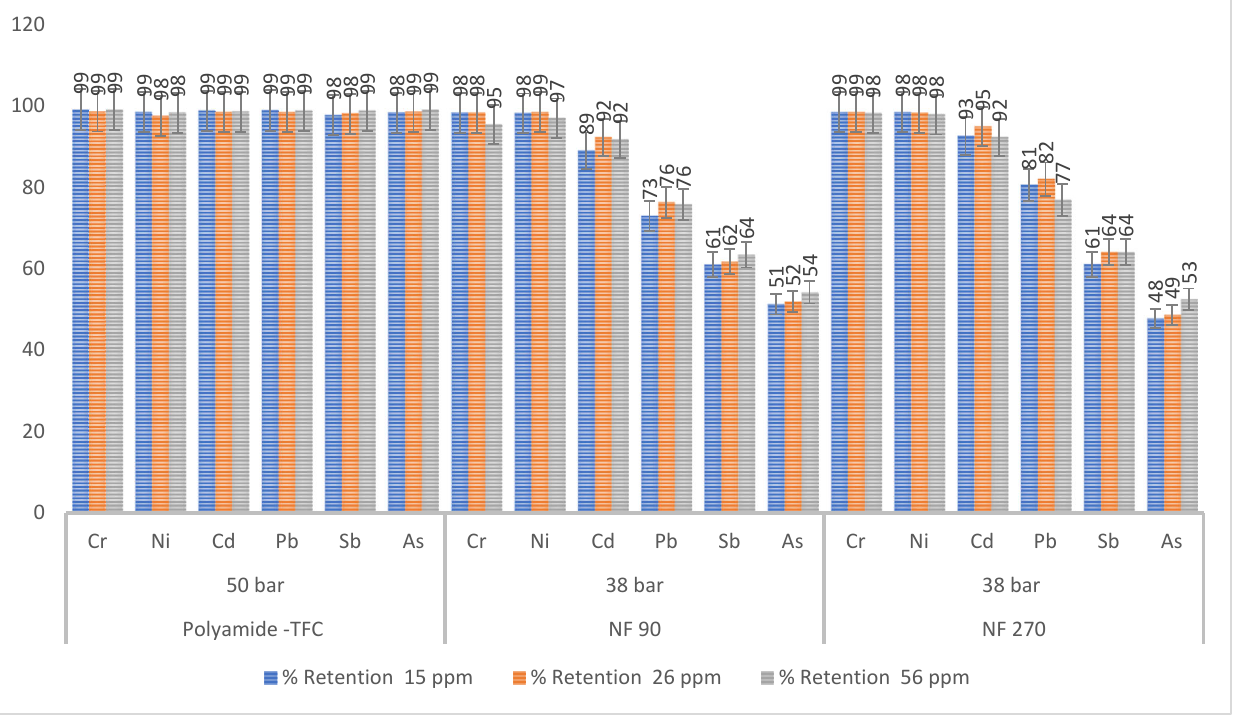
Figure 3. Removal of heavy metals as a function of feed concentration.